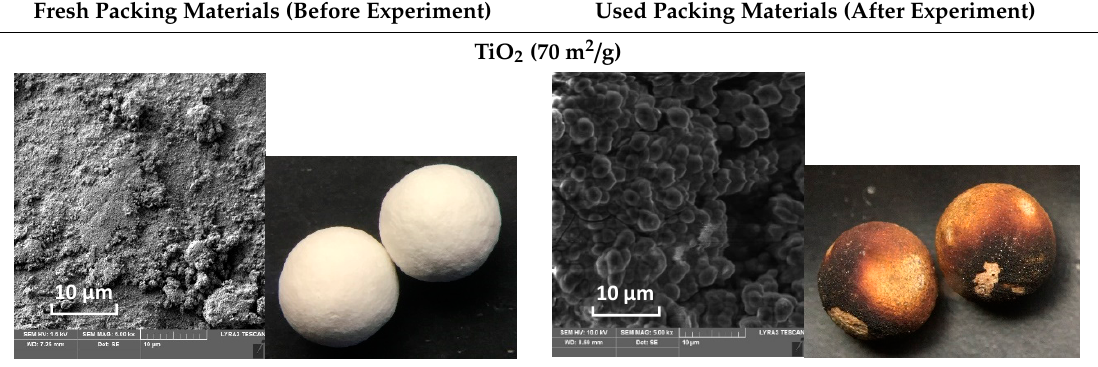
Table 1. SEM and optical microscope images of fresh, i.e., before experiment (left column), and used, i.e., after the experiment (right column), selected packing materials (magnification in optical microscope images: 160×).